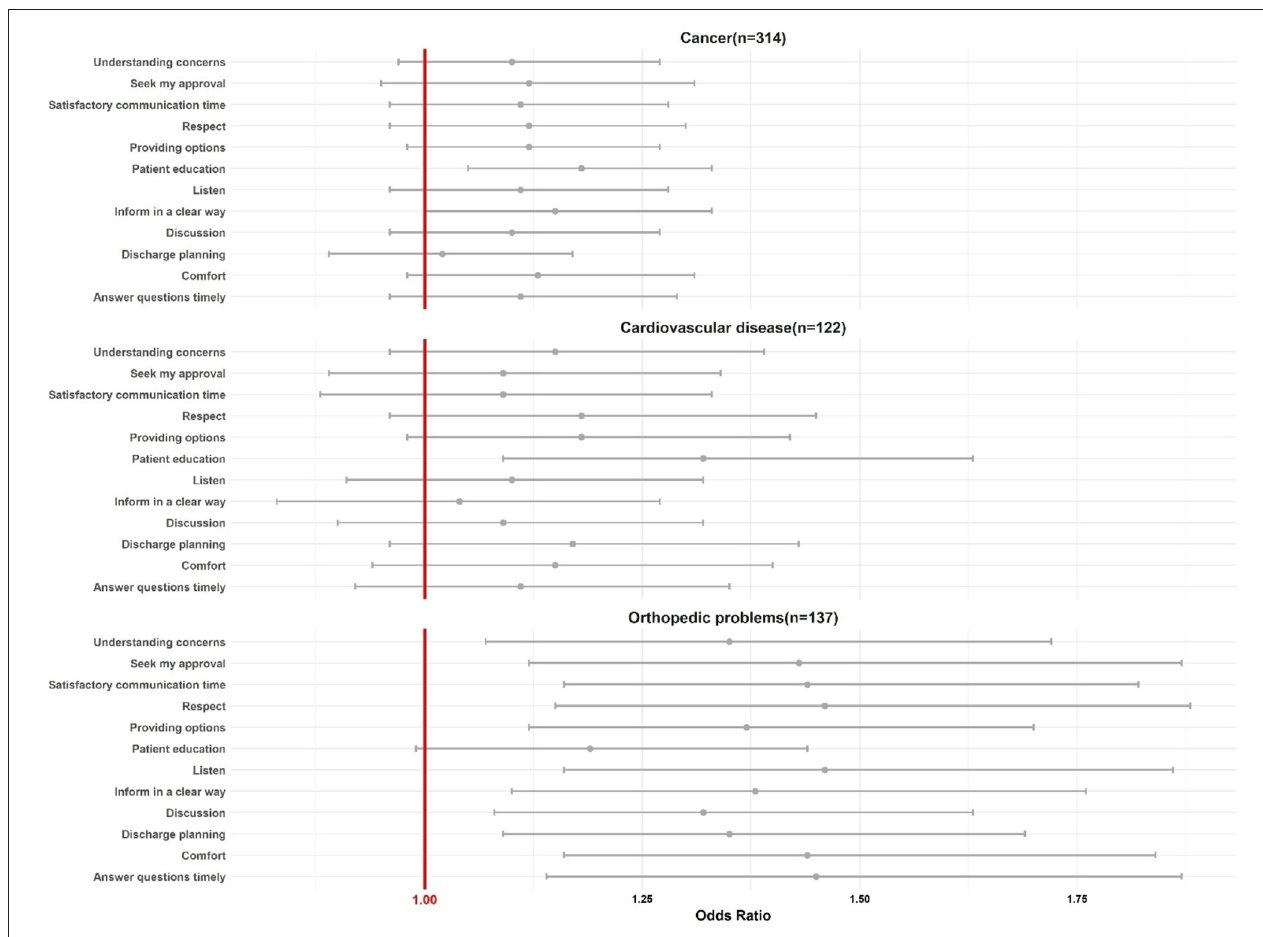
FIGURE 2 | The odds ratio of developing depression predicted by satisfaction with PE among patients with the three most reported diseases.